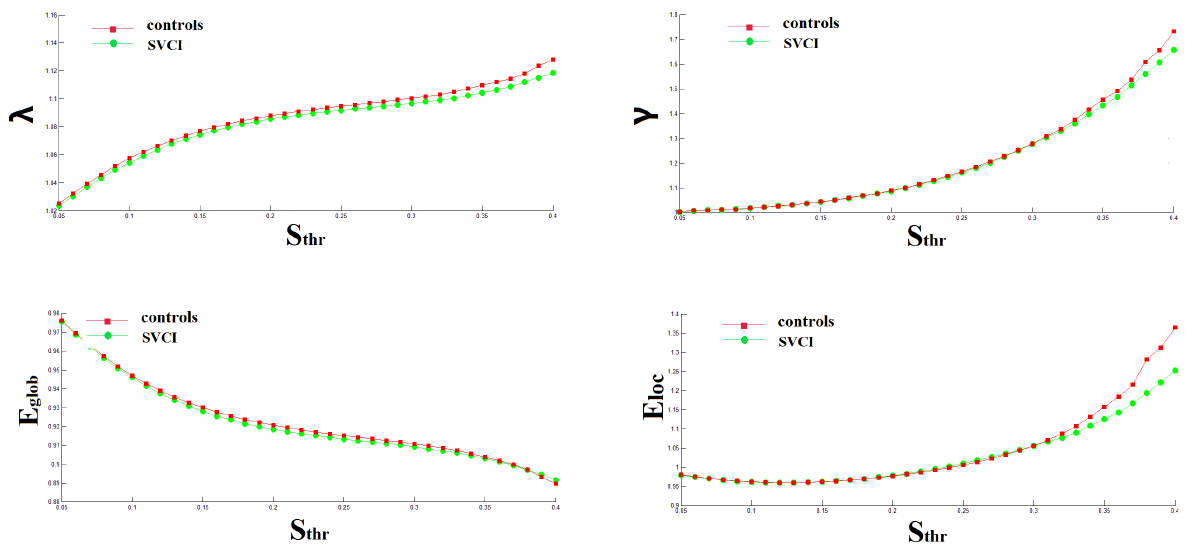
Fig 1. The mean global small-world network metrics of brain networks in healthy controls (red) and patients SVCI (green) as a function of sparsity threshold. λ = normalized shortest path length, γ = normalized clustering coefficient, E glob = global efficiency, E loc = local